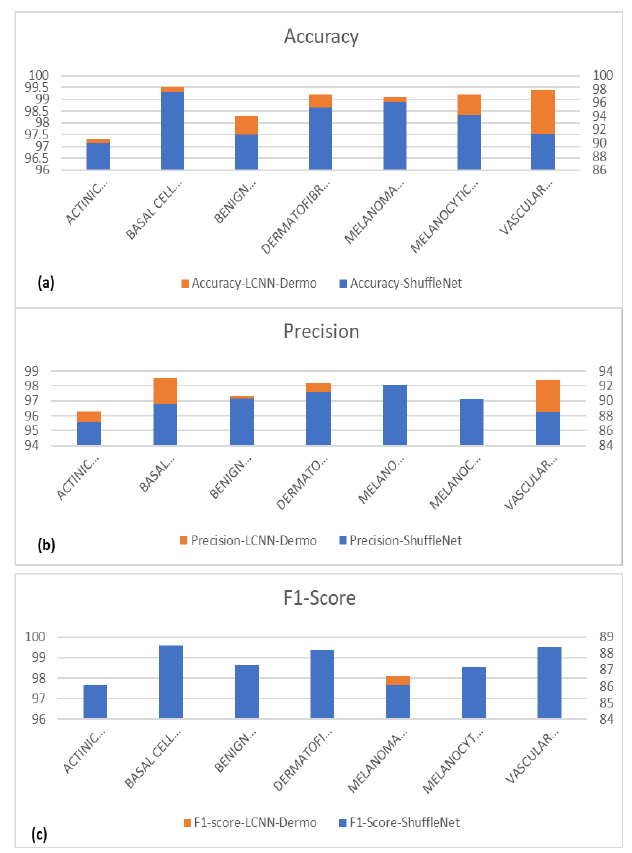
Figure 11. Classification results of the basic ShuffleNet and ShuffleNet-Light in terms of accuracy, precision, and F1-score.